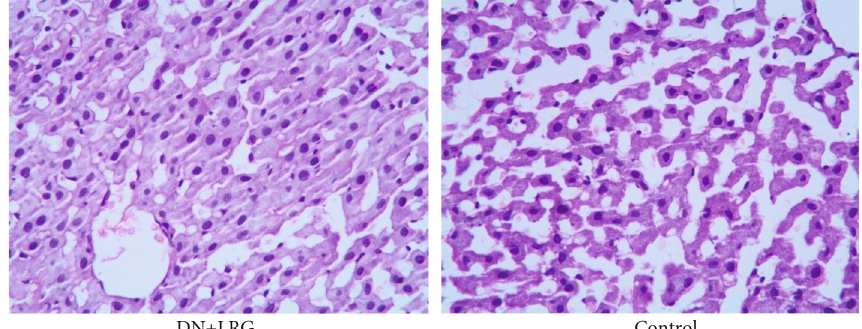
Figure 17: Hematoxylin eosin staining of the liver ( × 400). Control: diabetic nephropathy group; DN+LRG: diabetic nephropathy+liraglutide